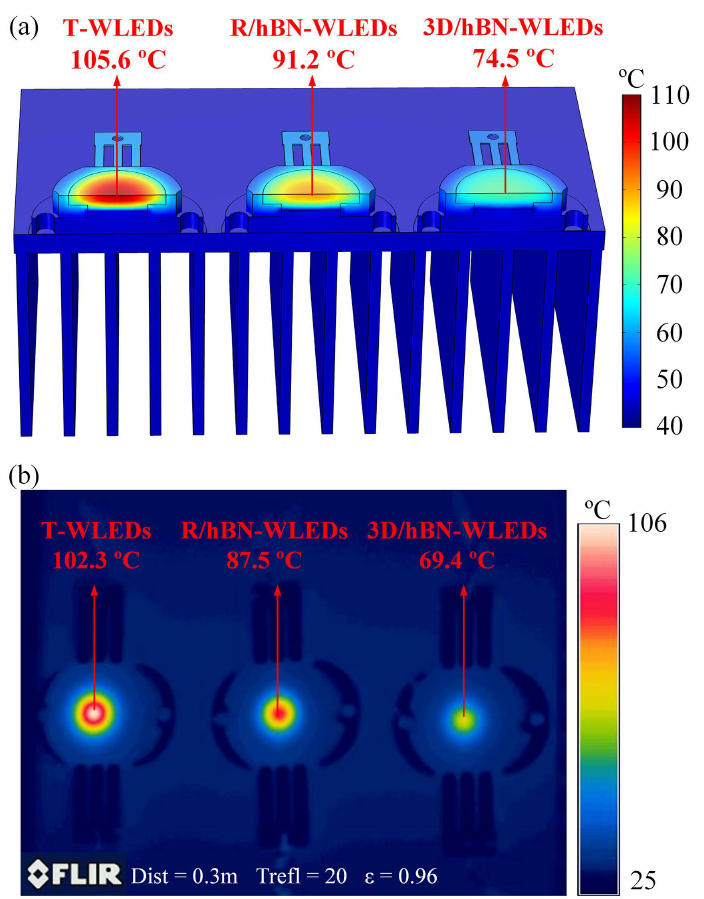
Figure 8. ( a ) Simulated and ( b ) measured temperature fields of these WLEDs under 500 mA illumi-